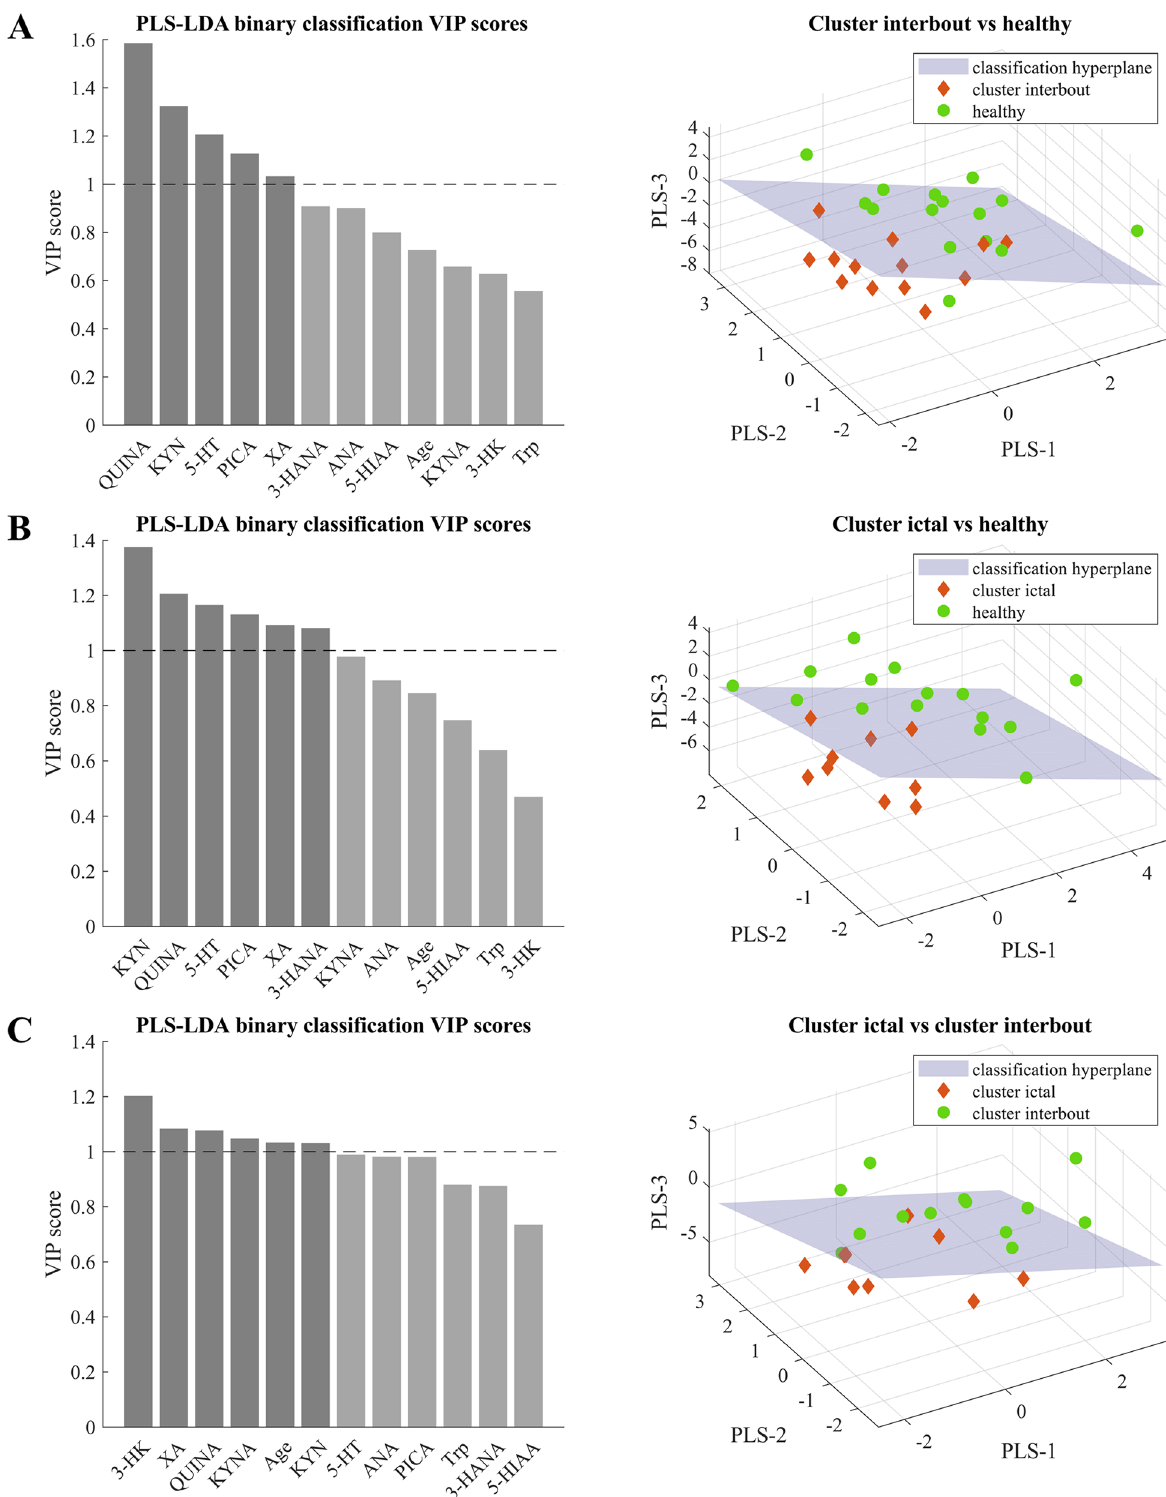
Fig. 2 a , b and c Linear relationships between the disease duration and plasma levels of interbout QUINA, as well as the total number of CH attacks and plasma levels of interbout KYN. Median of data and value of interquartile range were represented in the figures. KYN: L-kynurenine, QUINA: quinolinic